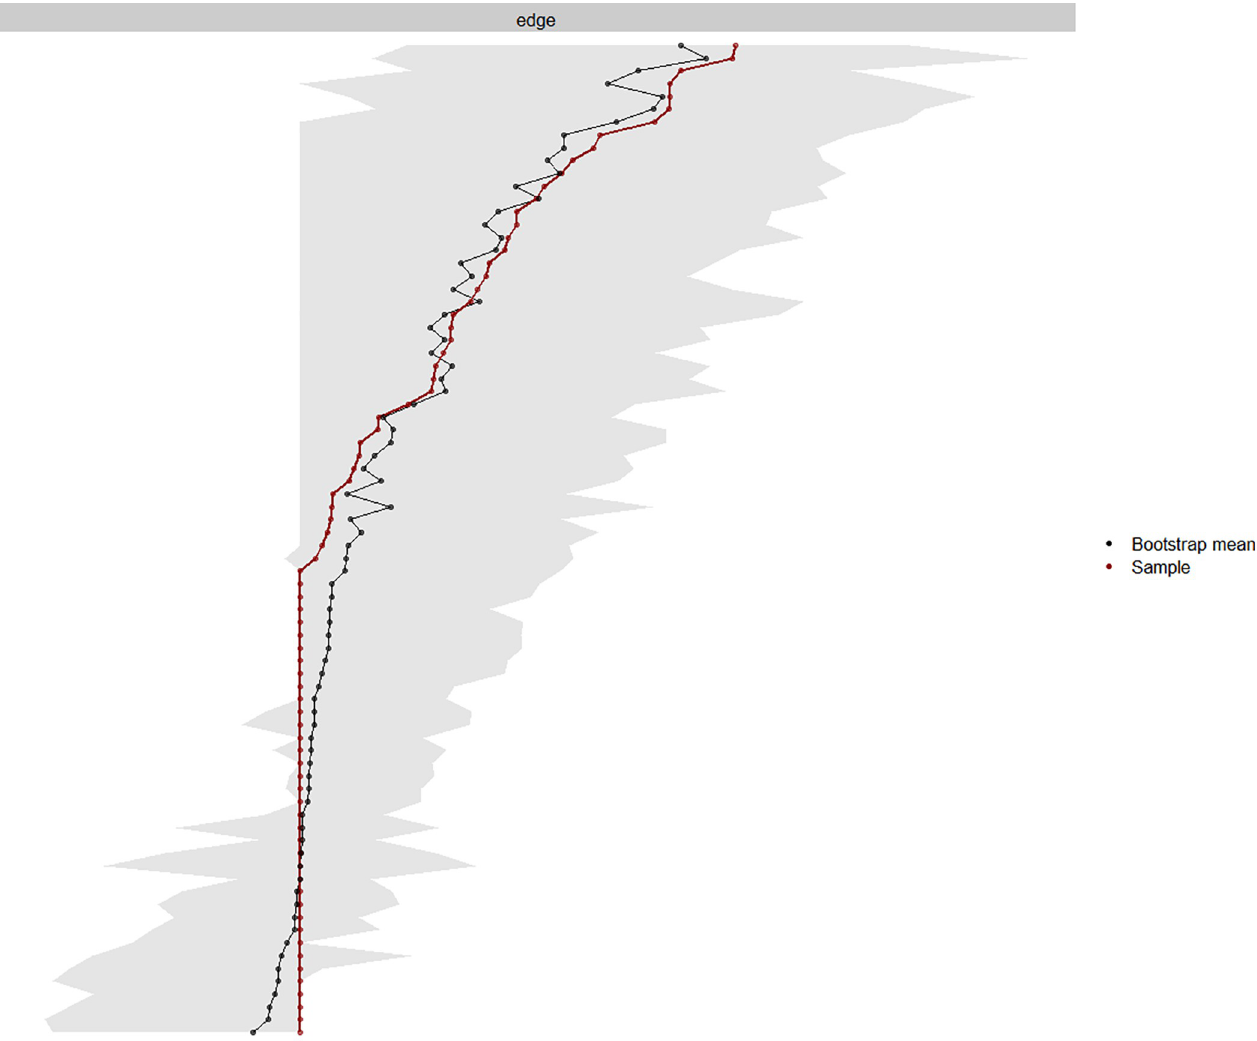
Fig 3. Bootstrapped 95% confidence interval of the estimated edge weights of the network. ‘Bootstrap mean’ represents the mean value of edge weights across the bootstrapped samples. ‘Sample’ represents the magnitude of edge weights of the original network built on the original dataset.